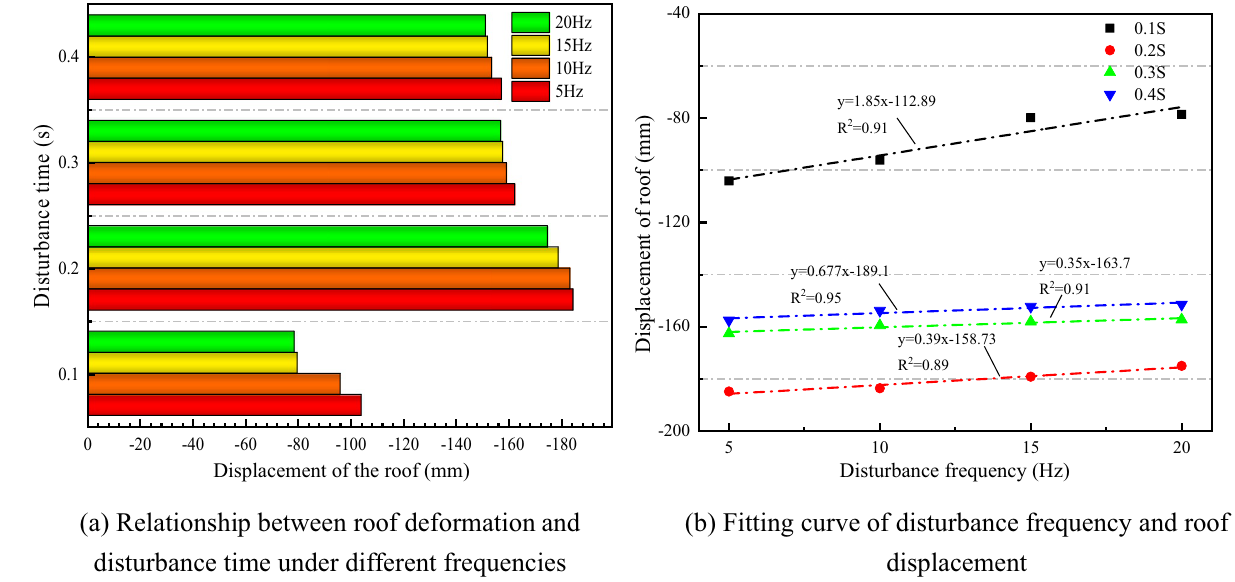
Figure 8. Variation rule of roof displacement under different disturbance frequencies.